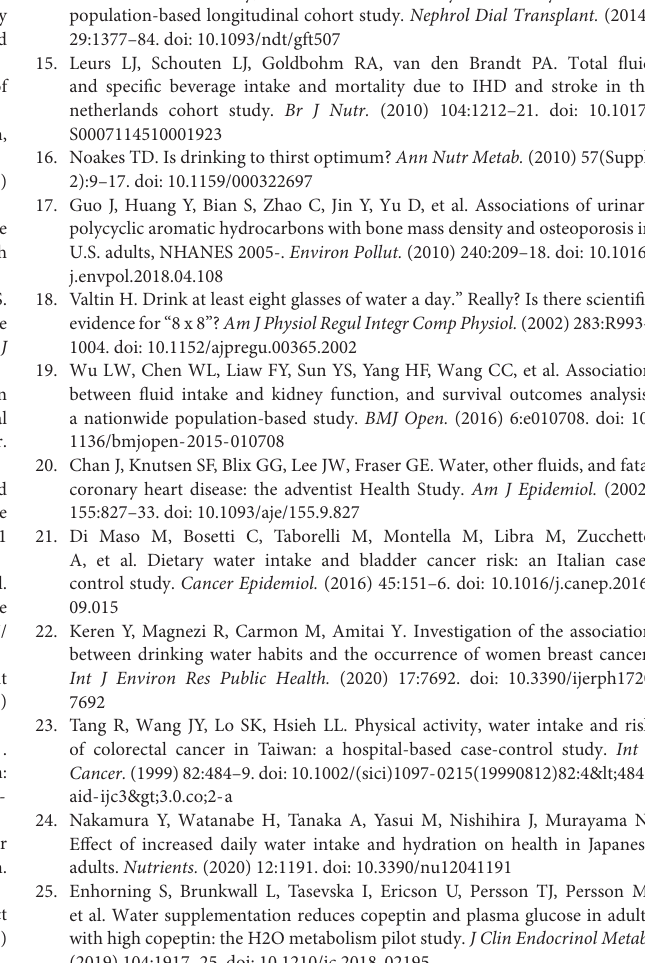
Supplementary Figure 1 | Flow chart for the selection of participants. Supplementary Figure 2 | Cluster analysis of medical history. Supplementary Figure 3 | The dose–response relationships of the amount of water intake [expressed by total water (A) , plain water (B) , beverage water (C) , and food water (D) ] with the mortality risk due to all causes in men clarified by restricted cubic spline plots.